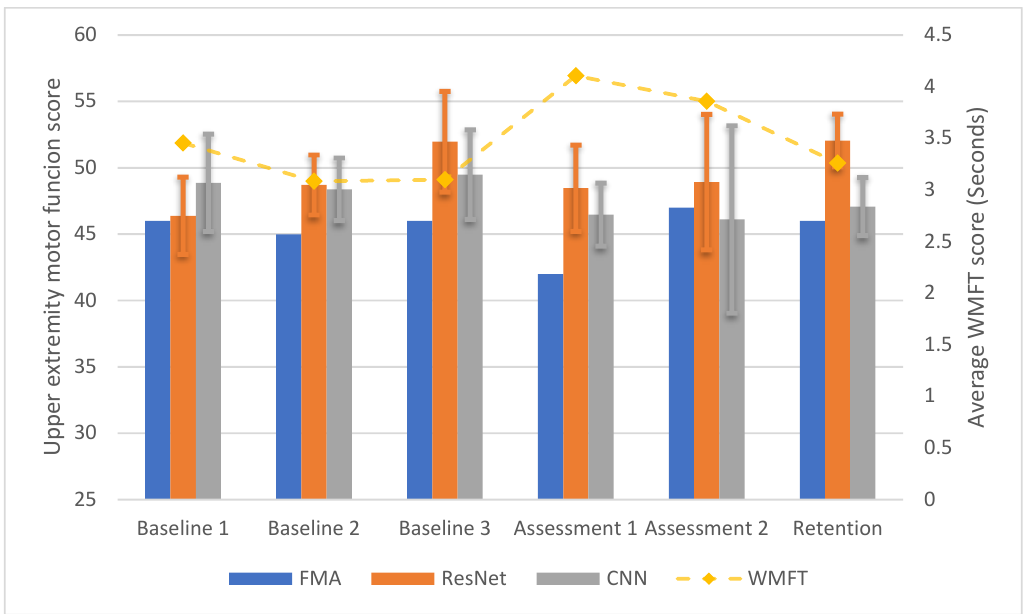
Figure 7. The longitudinal test results of the ANN models with EEG data collected from P1, when P1′s data were removed from the pool data, which was collected approximately 12 months before the study introduced in this paper.